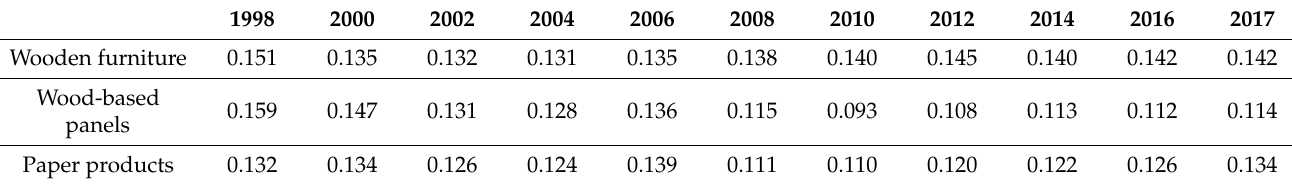
Table 4. Standard deviation of quality of Chinese major wood forest products.